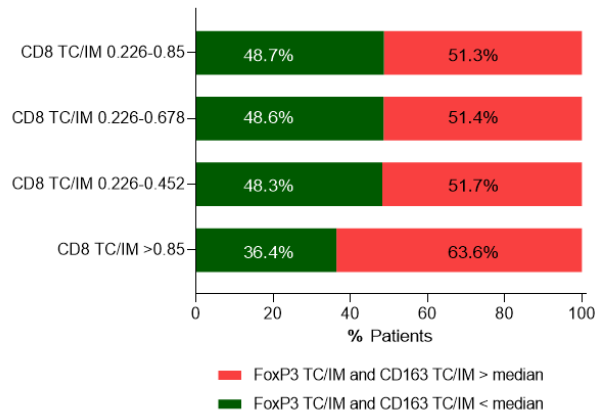
Figure 7. Correlations between CD8+ TC/IM ratios and CD163+TC/IM and FoxP3+ TC/IM ratios. For each CD8+ TC/IM ratio, the percentages of patients with CD163+ TC/IM and FoxP3+ TC/IM ratios above median are presented in red color. Accordingly, the percentages of patients with CD163+ TC/IM and FoxP3+ TC/IM ratios below median are presented in green color.